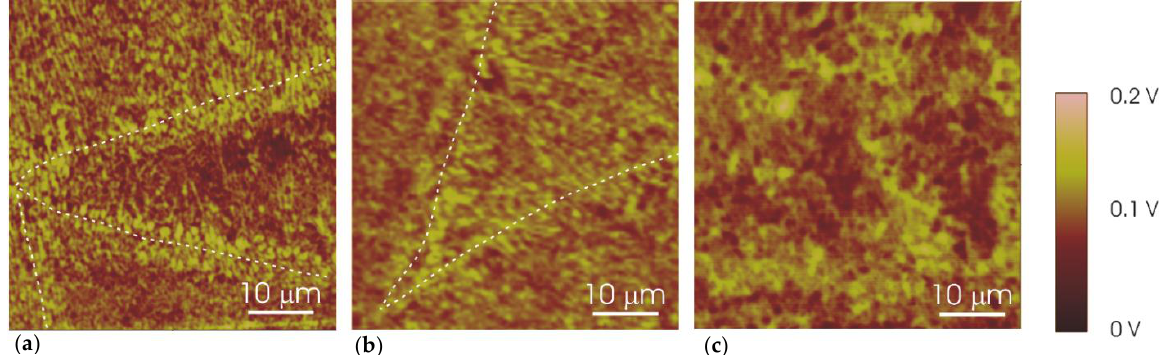
Figure 4. Scanning Kelvin probe force microscope (SKPFM) Volta potential maps for ( a ) UT, ( b ) 2h-300 and ( c ) 2h-400 specimens. The melt pool borders in the UT and 2h-300 specimens are highlighted with dashed lines. (XZ specimens).